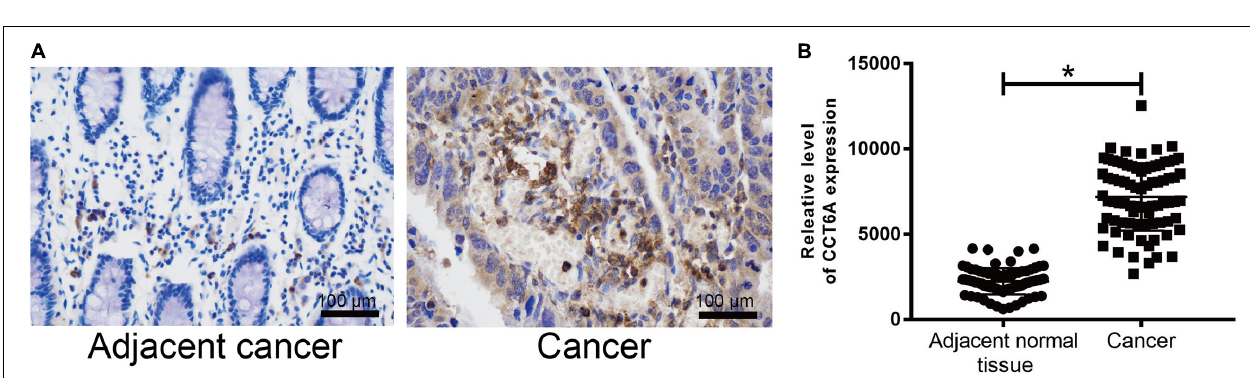
FIGURE 5 | CCT6A expression is up-regulated in COAD patients. (A,B) Immunohistochemistry was employed to test the protein level of CCT6A in COAD patients. Data are mean ± SE. * P < 0.05 vs. normal